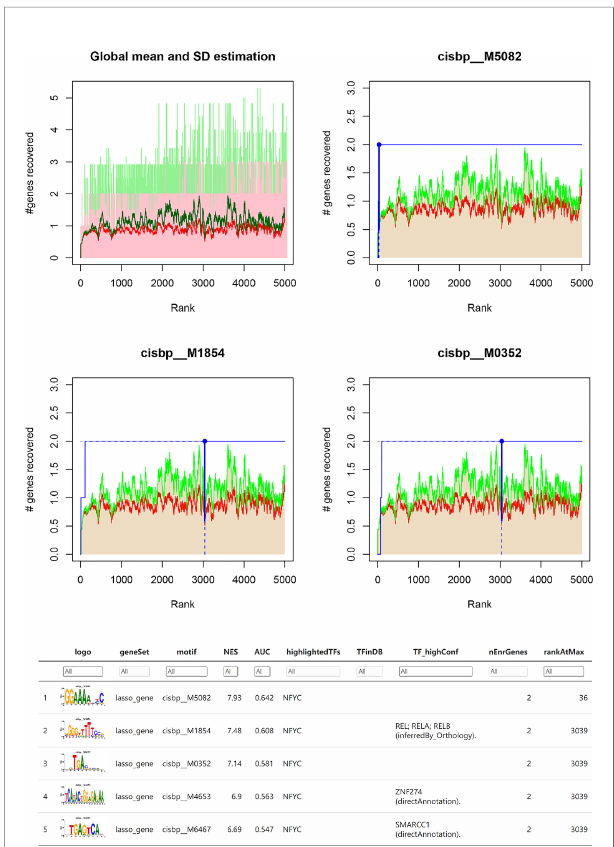
FIGURE 6 | Transcriptional regulation analysis among INHBA, OPRK1 and TPBGs.